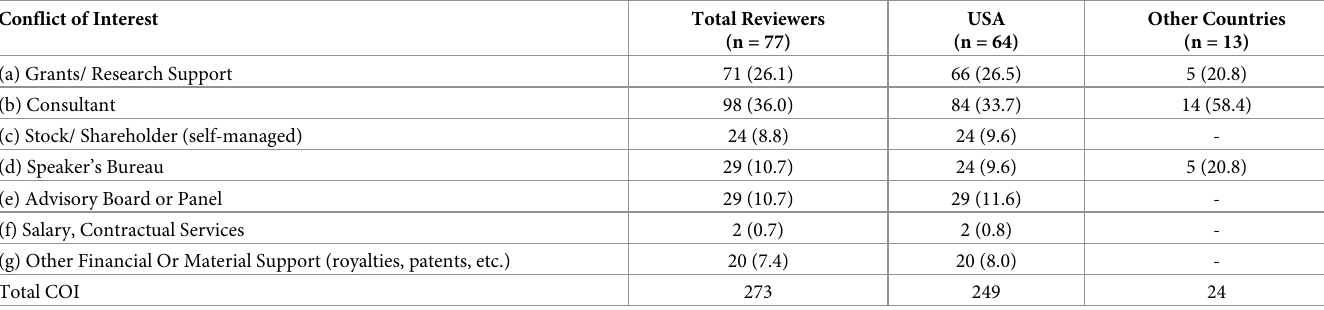
Table 1. Potential conflict of interest. Data are given in number, and percentages in parentheses. Conflict of